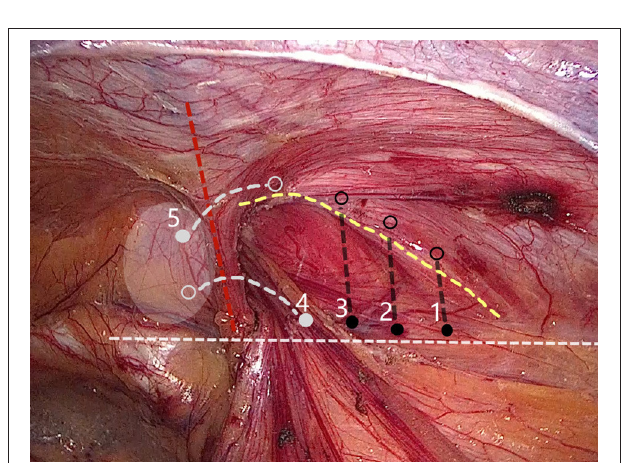
FIGURE 2 | Internal ring closure using a five-stitches method. (Solid dot: needle entry; open dot: needle